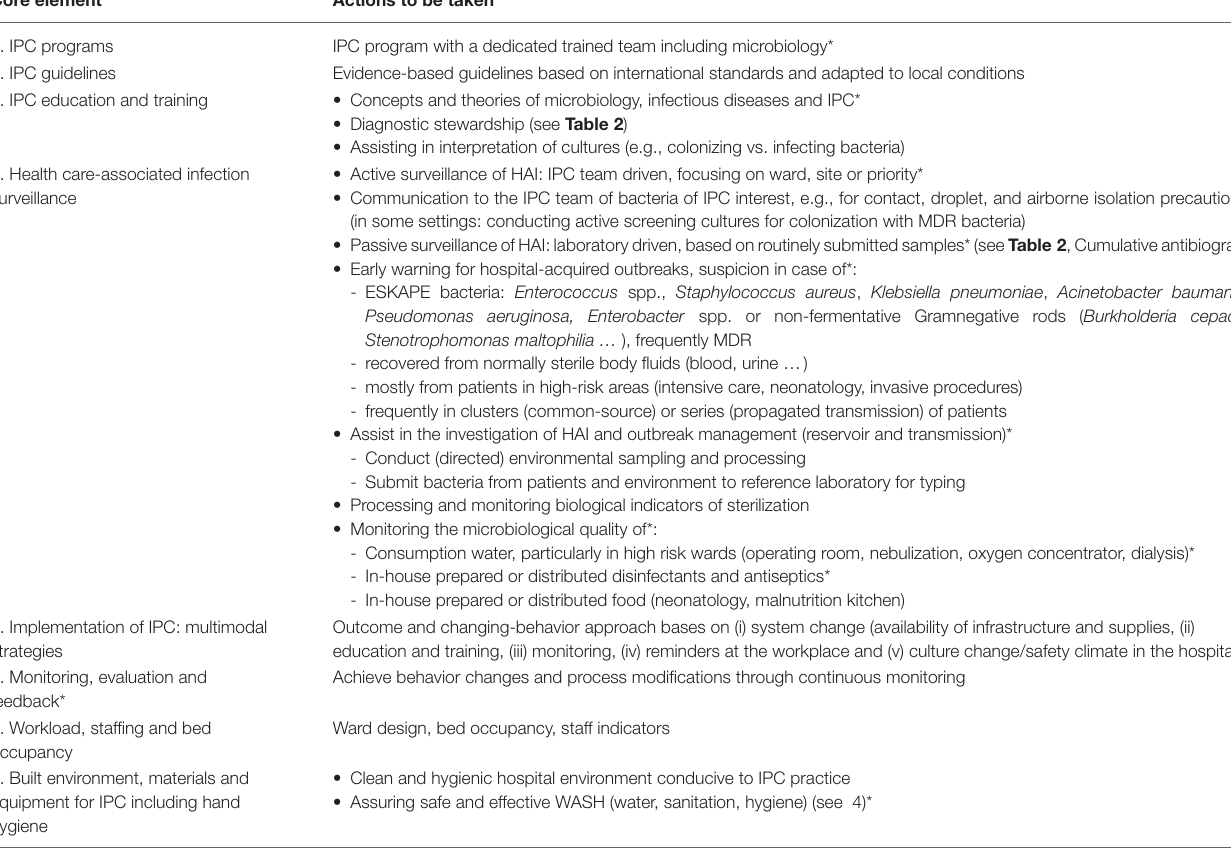
TABLE 3 | How the Clinical Bacteriology Laboratory can contribute to Infection Prevention and Control in hospitals. Core